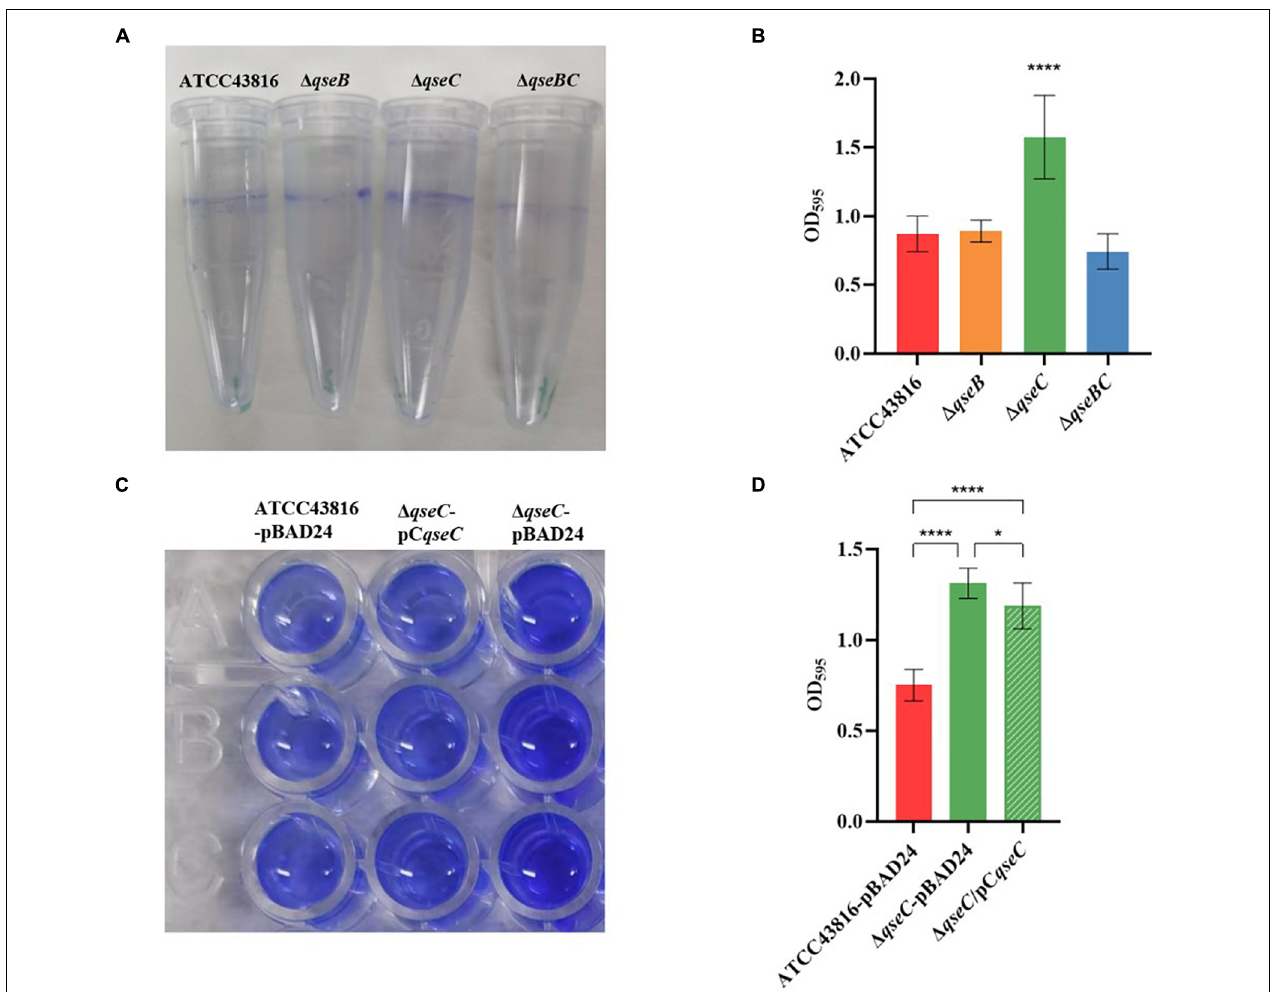
FIGURE 2 | (A) Detection of biofilm formed by ATCC43816, (cid:49) qseB , (cid:49) qseC and (cid:49) qseBC . Image of biofilm stained with 1% CV and adhered on plastic centrifuge tubes. (B) Biofilm were stained with 1% CV and washed with sterile water. The extracted color was dissolved with 33% glacial acetic acid and measured at OD 595 . Asterisks (****) represent statistically significant differences in biofilm formation between ATCC43816 and its qseC mutant ( P < 0.0001, t test). (C) Image of biofilm formed by ATCC43816-pBAD24, (cid:49) qseC -pBAD24 and the complement strain (cid:49) qseC -pC qseC . Biofilm were stained with 1% CV, washed with sterile water and then dissolved with 33% glacial acetic acid. (D) The extracted color was measured at OD 595 to show biofilm production. Asterisks (****) represent statistically significant differences in biofilm formation between ATCC43816-pBAD24 and (cid:49) qseC -pBAD24/ (cid:49) qseC -pC qseC ( P < 0.0001, t test). The biofilm formation of (cid:49) qseC -pC qseC was significantly lower compared with that of (cid:49) qseC -pBAD24 ( P = 0.0366, t